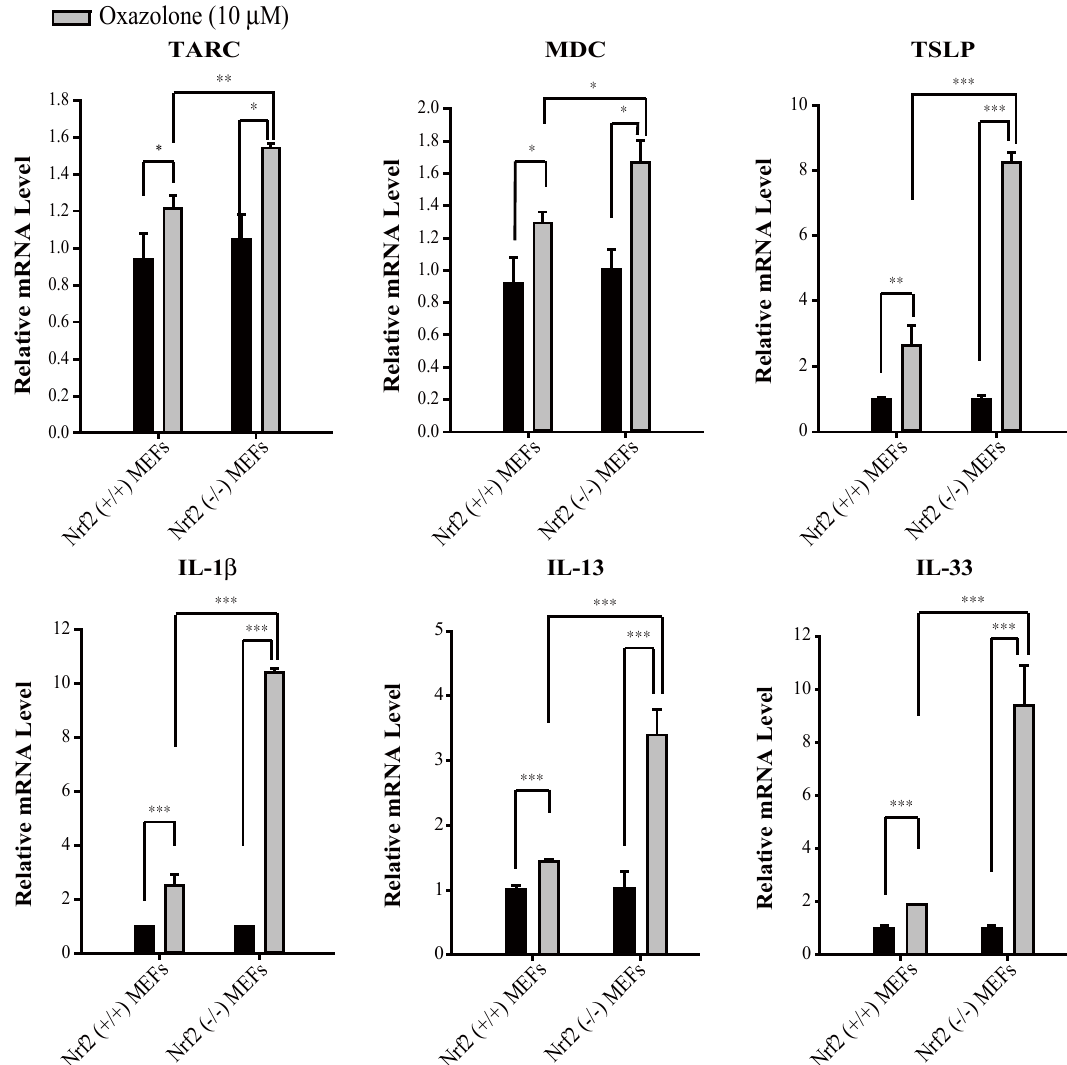
Figure 4. Transcriptional activation of Th2 cytokines by oxazolone is significantly higher in Nrf2 ( − / − ) MEFs compared with Nrf2 (+/+) MEFs. Primary Nrf2 (+/+) and Nrf2 ( − / − ) MEFs were exposed to oxazolone (10 μ M) for 24 h and real-time PCR was performed using specific primers against Th2 cytokines. Asterisks indicate a statistical significance of * p < 0.05, ** p < 0.01 and *** p < 0.001.